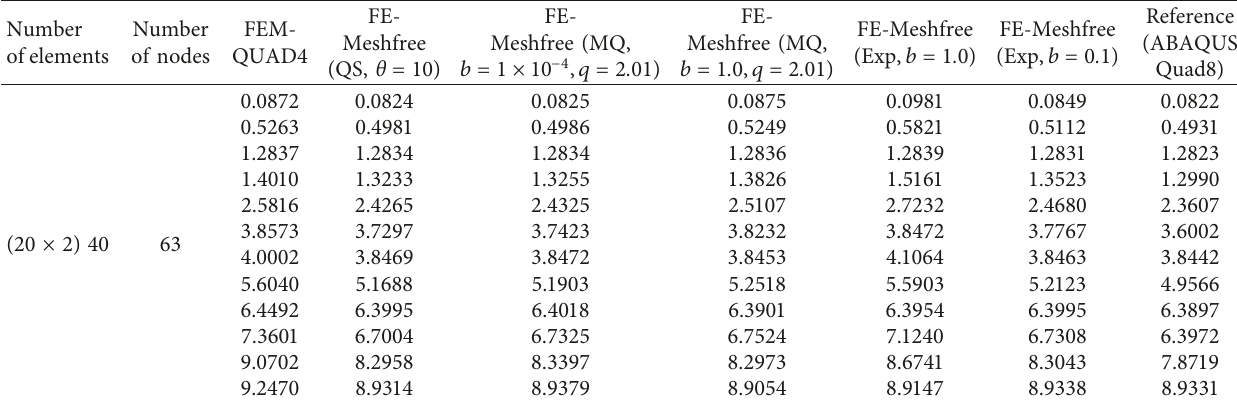
Table 5: Natural frequencies ( × 10 4 Hz) of a cantilever beam for 40 elements.